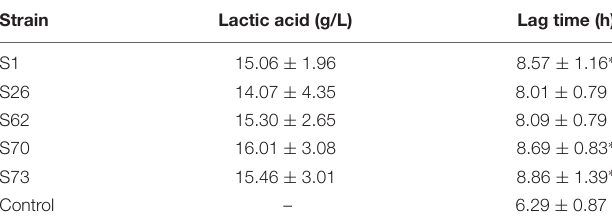
of the candidates.